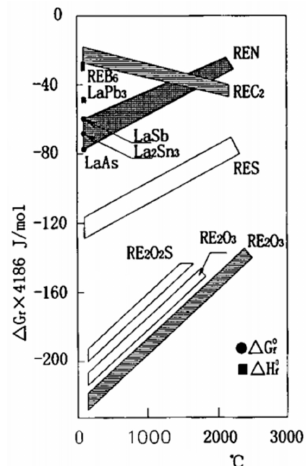
Figure 6. Relationship between the standard Gibbs free energy of formation and temperature of some rare earth compounds